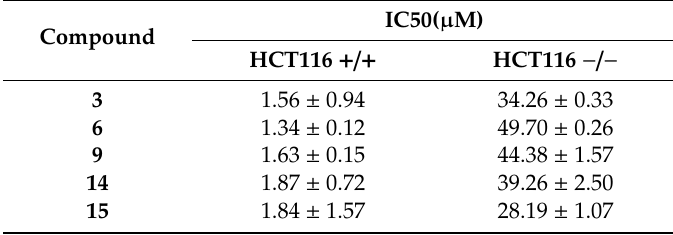
Table 2. The antiproliferative activities of selected compounds for HCT116 (p53/) cells.